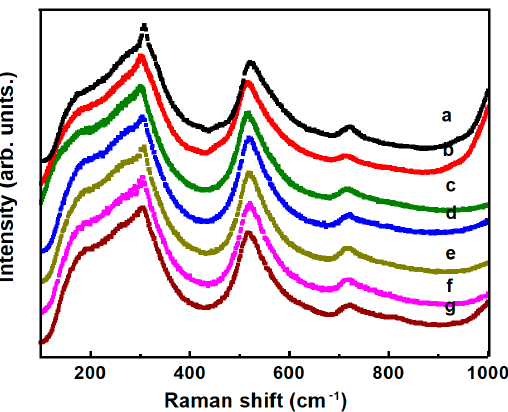
Figure 2. Raman spectra of pure BT-NBT ceramics and Yb-Mg codoped BT-NBT ceramics at room temperature, where (a) undoped BT-NBT; (b) x = 0; (c) x = 0.005; (d) x = 0.01; (e) x = 0.015; (f) x = 0.02; (g) x = 0.025.